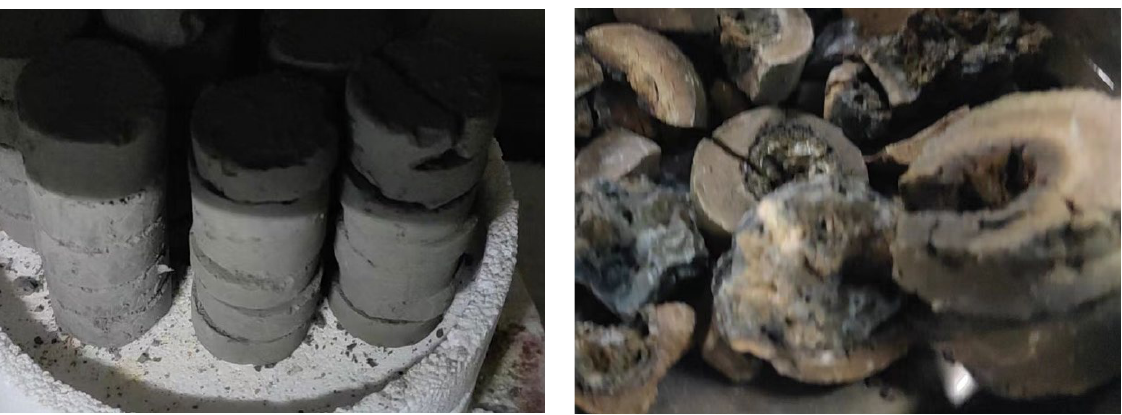
Figure 9. Preparation of CAS clinker by high temperature calcination. Table 6. Contents of S2 samples fired at different temperatures (wt.%).